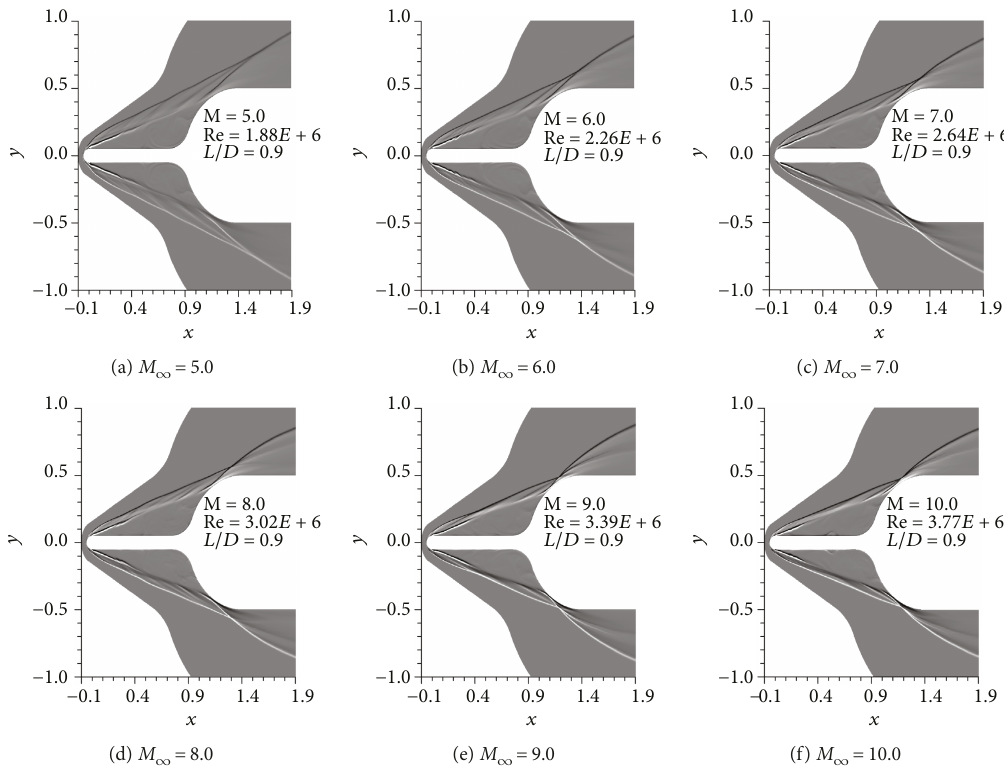
Figure 13: Flow fi eld density gradient in y direction of spiked blunt bodies with the sideward sonic jet. Spike length L/D = 0.9.